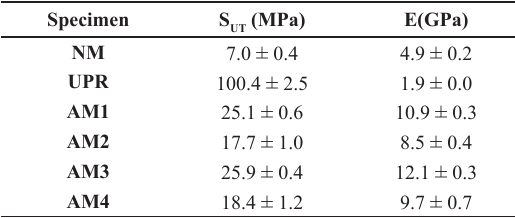
Figure 4. Ultimate strength (S ) and Elastic Modulus (E) of produced artificial marbles (AM1, AM2, AM3, AM4). Mean + standard UT Table 3. Flexural properties of raw materials and produced artificial marbles (means ± standard error).